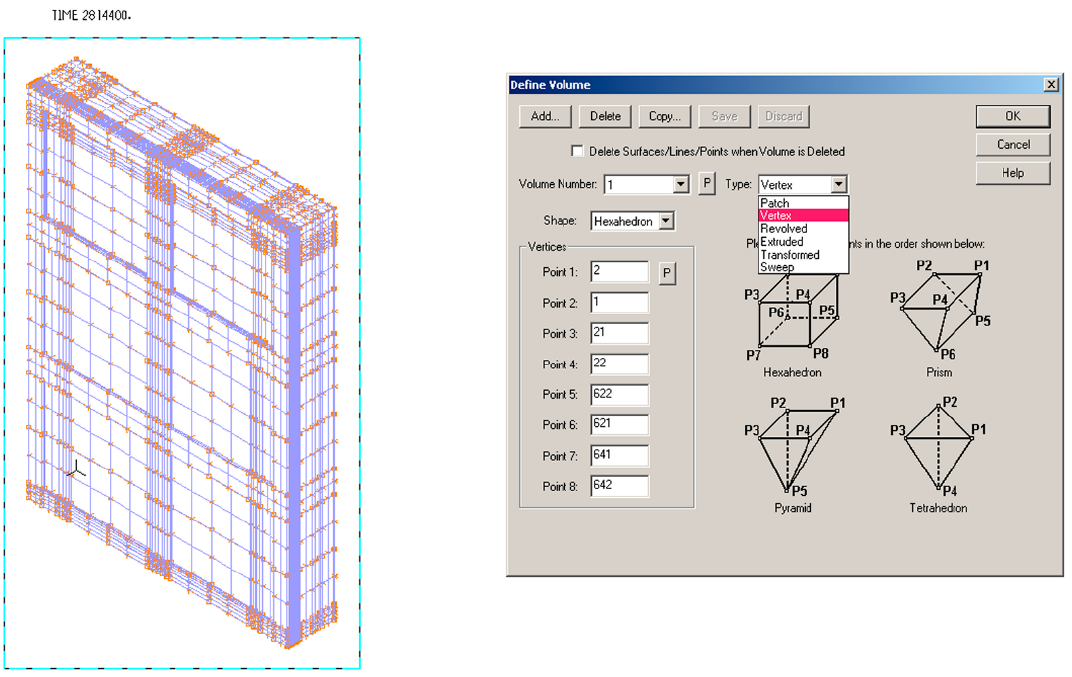
Figure 10. View of the numerical model of the wall.